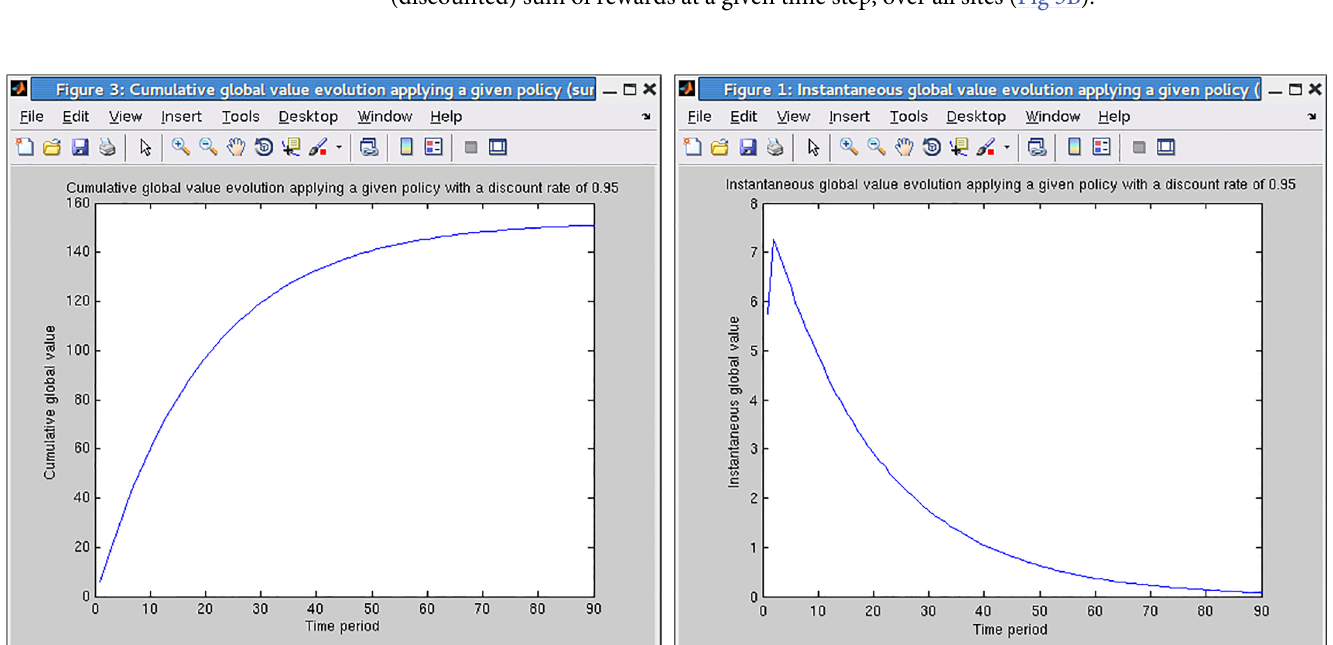
PLOS ONE | https://doi.org/10.1371/journal.pone.0186014 October 5,